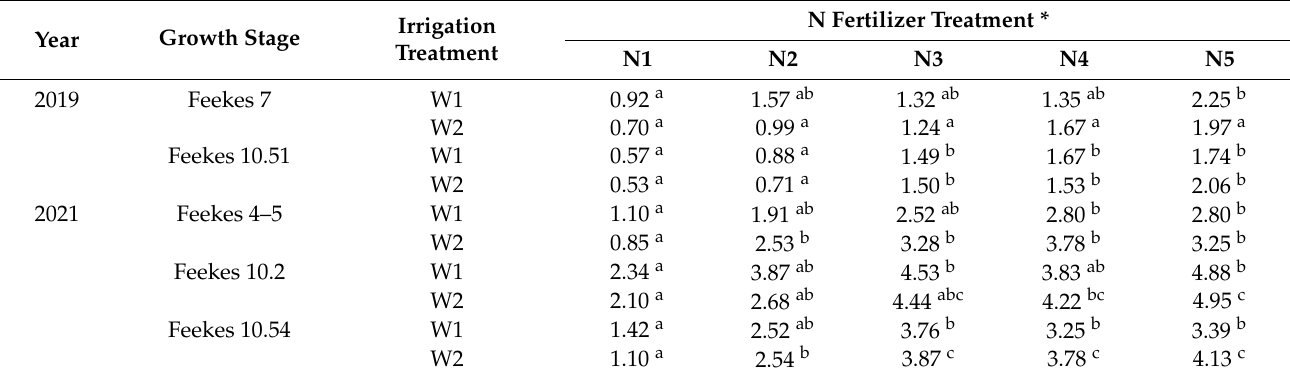
Table 2. Results of significance tests for LAI under different irrigation and N treatments at different winter wheat growth stages in different